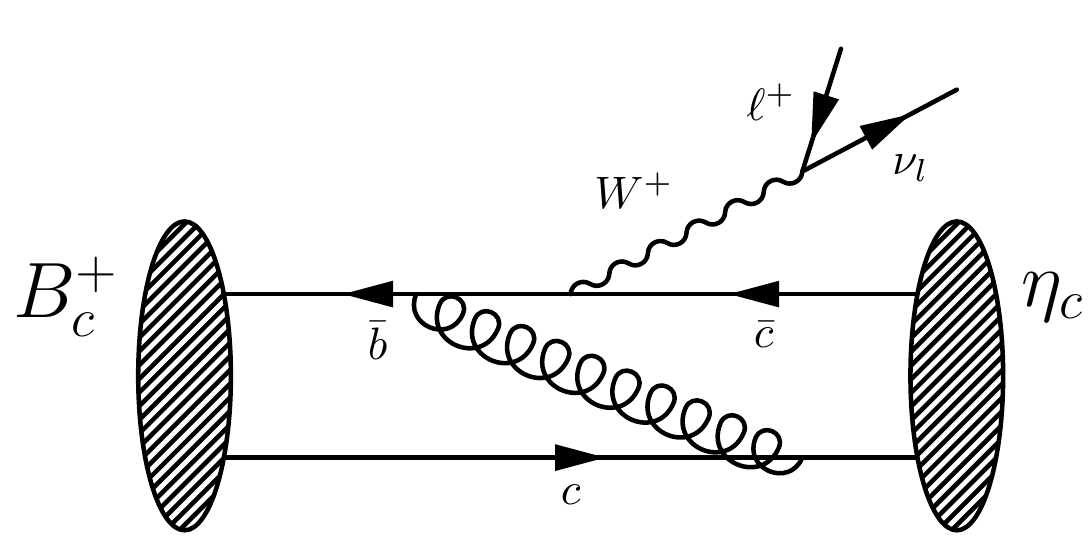
Figure 1 . Schematic picture of the B +